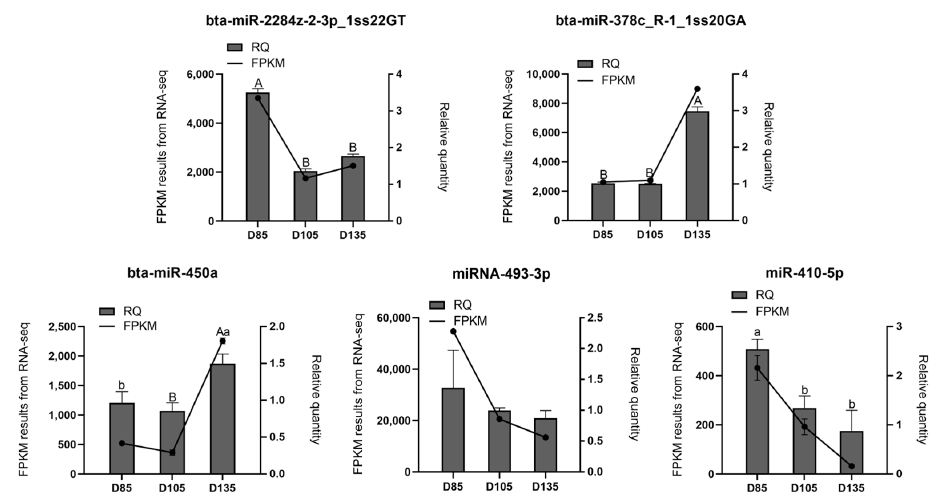
Figure 3. Validation of the small-RNA sequencing data: the polyline graph shows the FPKM value of the sequencing, and the histogram shows the relative quantitative results; a and b indicate a significant difference, and A and B indicate an extremely significant difference.